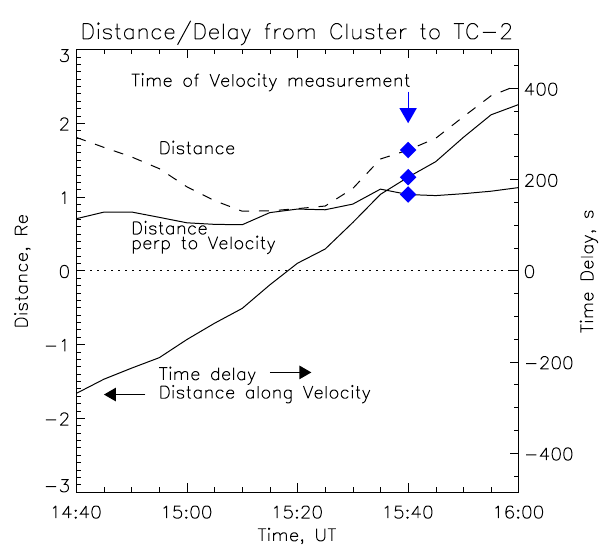
Fig. 6. Components of the relative TC-2 position vector along and transverse to the velocity of Injection 3 (blue diamond) and mapped at the Cluster altitude (solid lines). The dotted line shows the mapped distance between the two spacecraft. The scale on the right gives the expected delay between observations at Cluster and